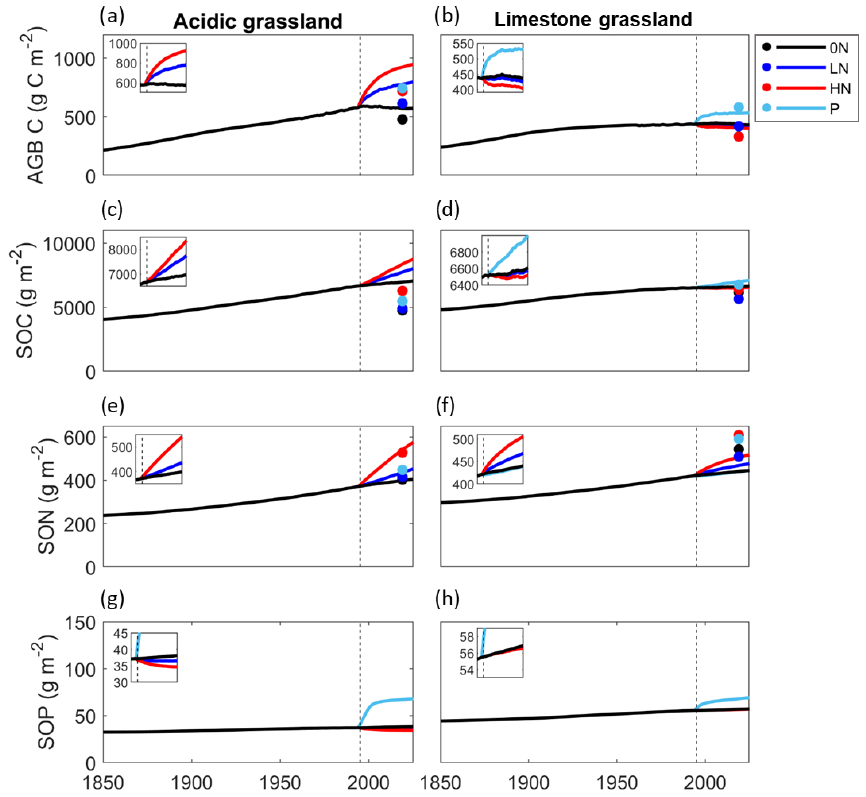
Figure 4. Time series plots of aboveground biomass C and soil organic C, N, and P for the acidic (panels a , c , e , and g respectively) and limestone modelled grasslands (panels b , d , f , and h respectively). The vertical dashed line represents the first year of nutrient addition (1995) and marks the beginning of the experimental period. The inset subplots focus on this experimental period (1995–2020) and highlight changes occurring as a result of nutrient additions rather than background N deposition. All nutrient treatments at Wardlow are represented in all panels, though not all lines are visible if they do not differ from 0N. Both grasslands share a y axis. Empirical data from Fig. 2 are plotted on the respective panels, with the exception of panels g and h, where empirical data are incompatible with modelled data (total P versus organic